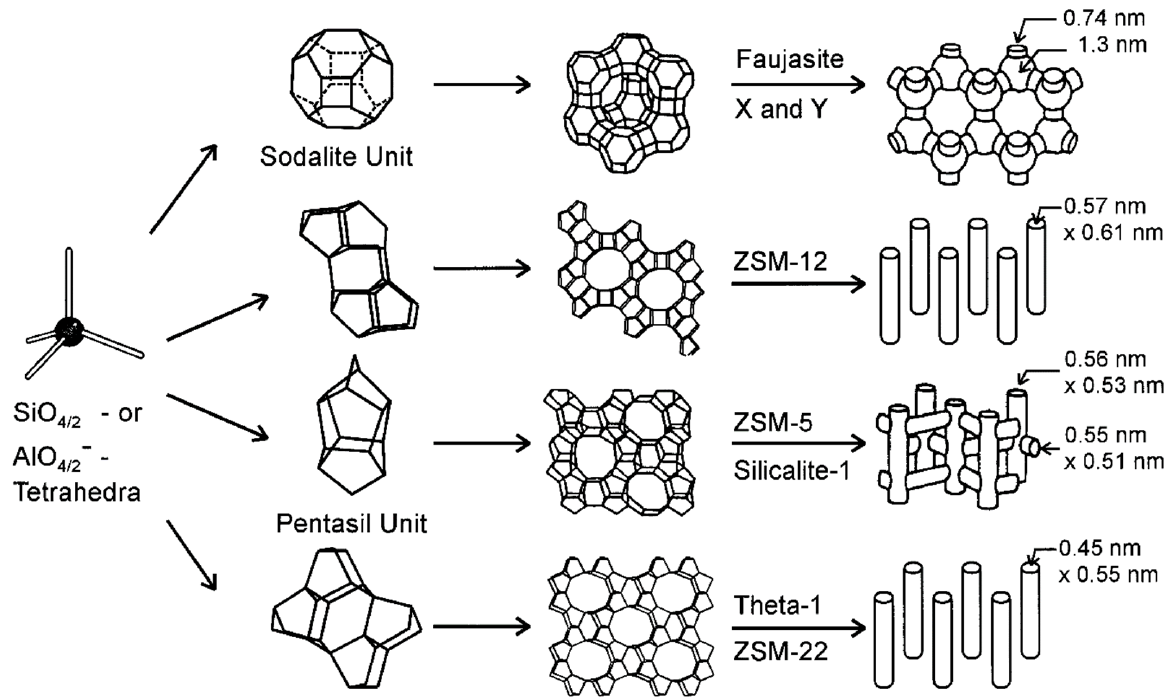
Figure 3. Structures of four selected zeolites (from top to bottom: faujasite or zeolites X, Y; zeolite ZSM-12; zeolite ZSM-5 or silicalite-1; zeolite Theta-1 or ZSM-22) and their micropore systems and dimensions [134] (reprinted from Publication Solid State Ion. 131, J. Weitkamp, Zeolites and catalysis, 175–188 (2000) with permission from Elsevier).